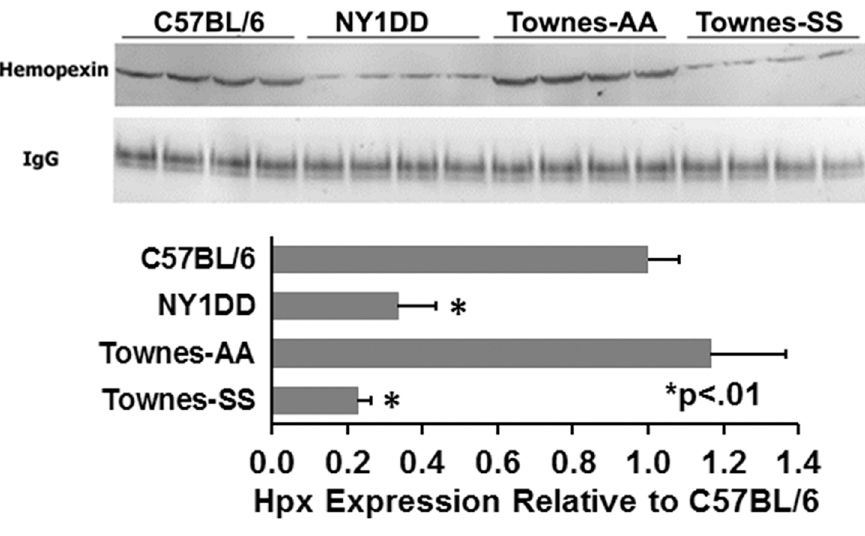
Figure 1. Plasma hemopexin is decreased in sickle mice. Plasma was collected from the abdominal aortae of C57BL/6, NY1DD, Townes-AA and Townes-SS mice (n = 4/group). Plasma (1 μ L) was run on western blots and immunostained for murine hemopexin (68 kDa) or IgG (155 kDa). Bar graph represents relative hemopexin band intensities (mean + SD)